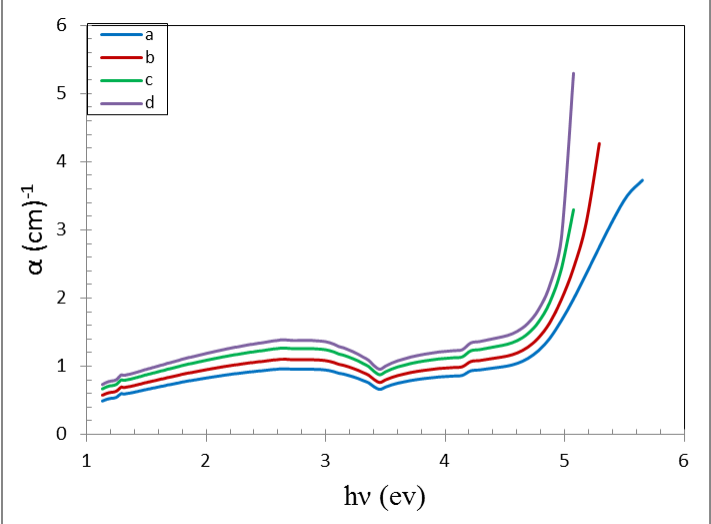
Fig.3: The absorption coefficient as a function of photon energy of glass for different doping concentrations of grapheme oxide thin films ((a) 2%, (b) 4%, (c) 6% and (d) 8% wt.